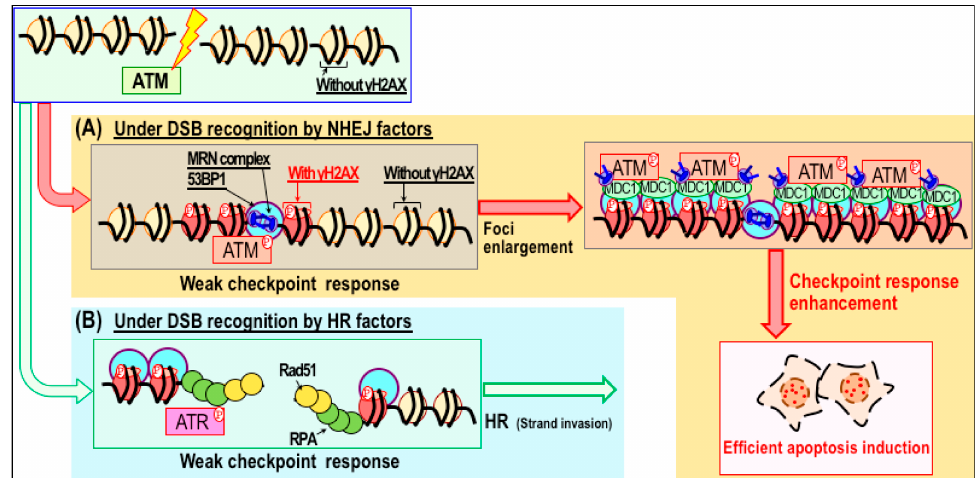
Figure 2. Model of checkpoint response enhancement through modulation of DNA repair